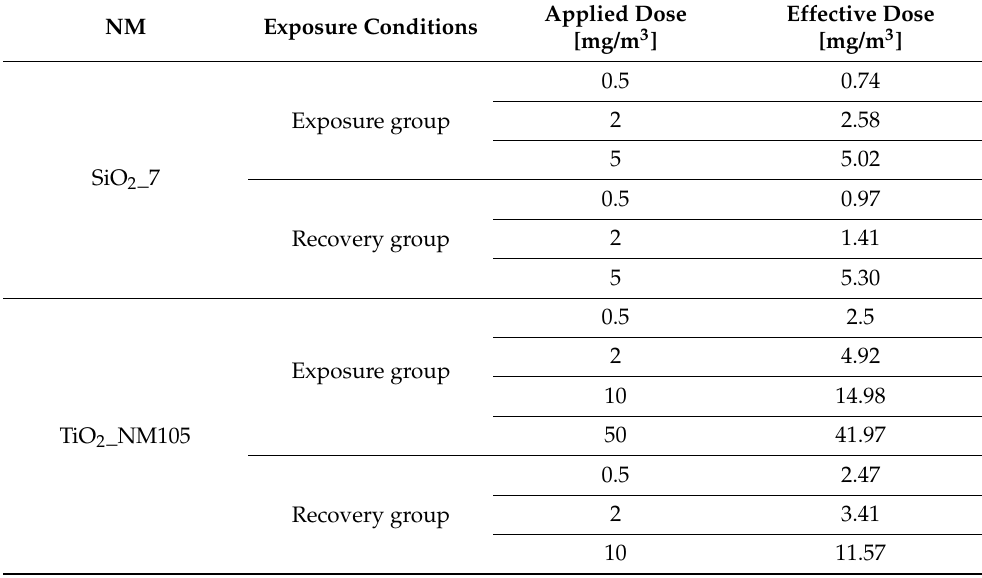
Table 1. Comparison of in vivo applied and calculated effective doses of SiO 2 _7 and TiO 2 _NM105 in